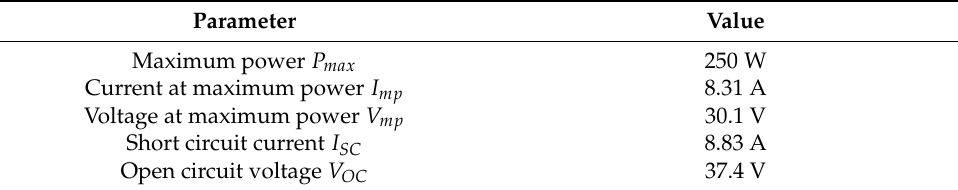
Table 3. Solar panel model